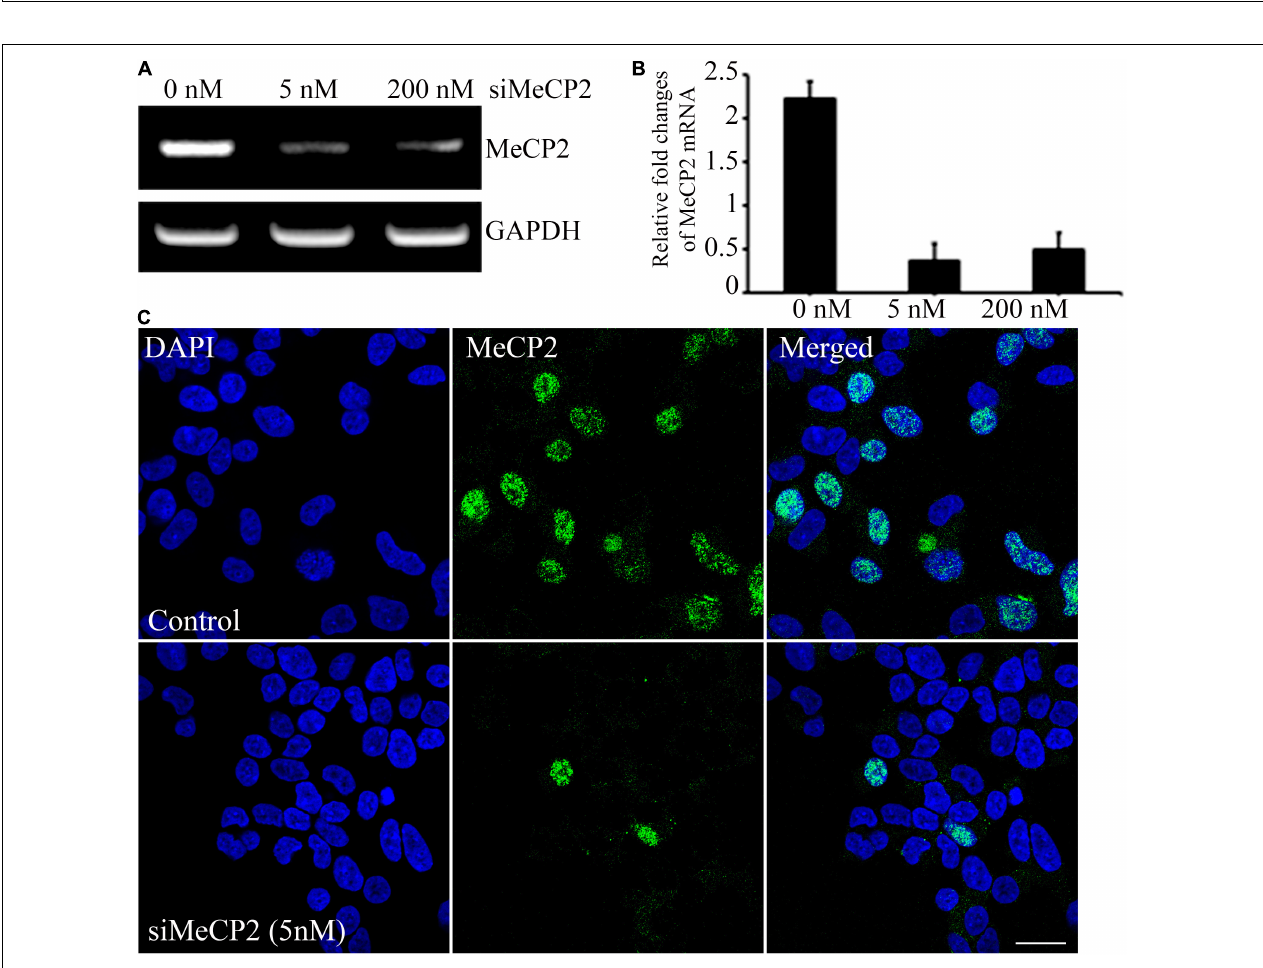
FIGURE 3 | Efficiency of MeCP2 silencing in SHSY-5Y neurons. (A) MeCP2 expression levels in knockdown cells, assessed using PCR, following treatment with different concentrations of MeCP2 siRNA. (B) Relative changes in expression are presented in a bar graph. (C) Immunohistochemistry for assessing the presence and localization of MeCP2. The cells were dual stained for the nucleus (blue) and MeCP2 (green) and observed using confocal microscopy. Scale bar = 50 µ m.